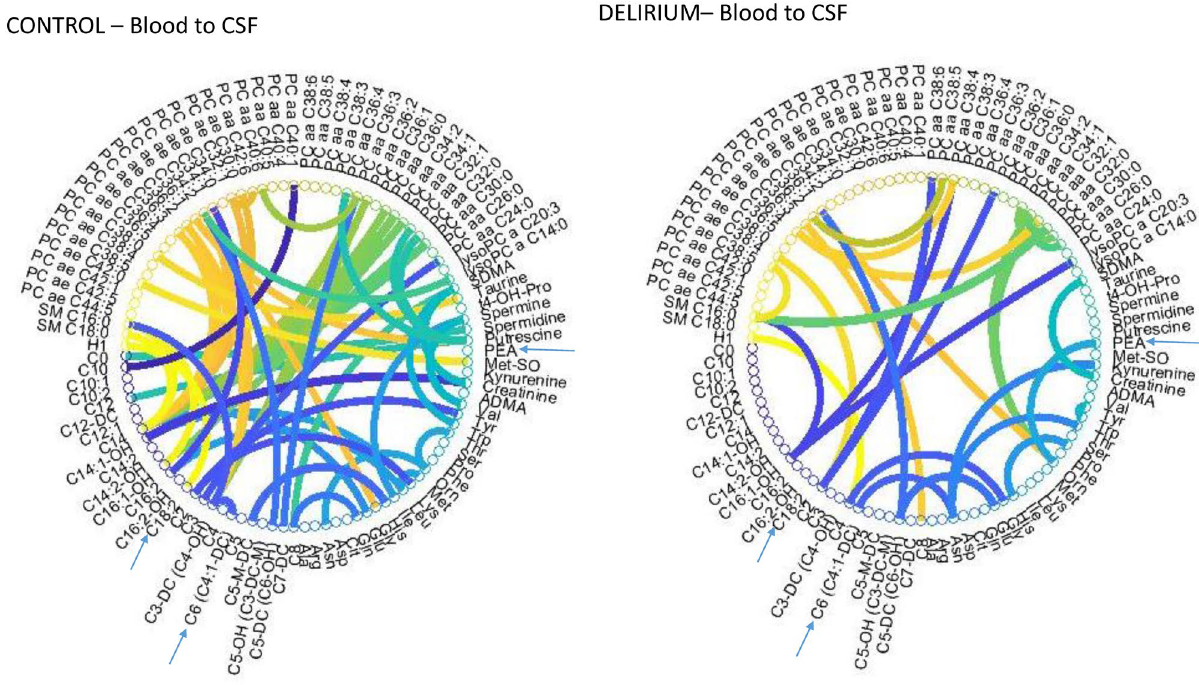
Figure 4. Distance correlation between metabolites in CSF and Blood in control and delirium-prone groups. Shown are correlations over 0.58. Figure is obtained using Matlab 2021a (Mathworks) Inc with cirularGraph (https:// github. com/ paul- kasse baum- mathw orks/ circu larGr